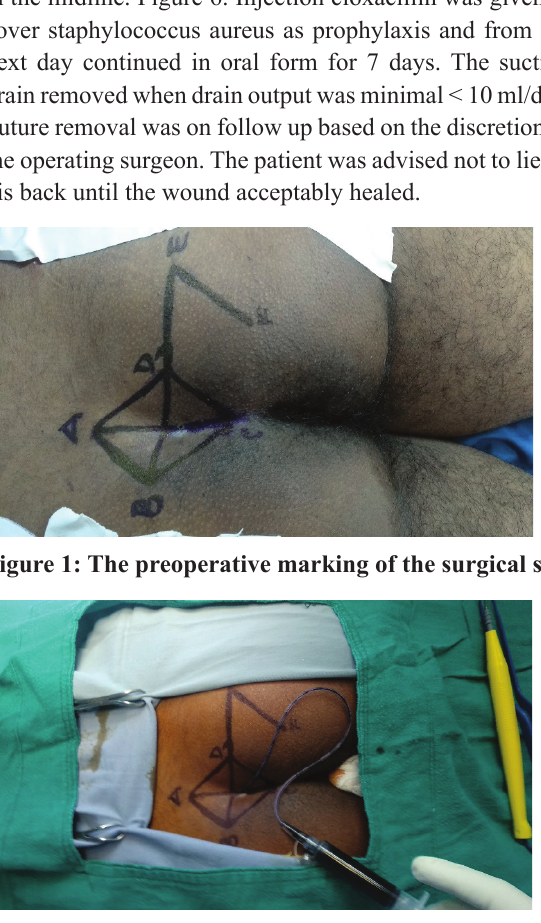
Figure 2: Methylene blue injected in the sinus